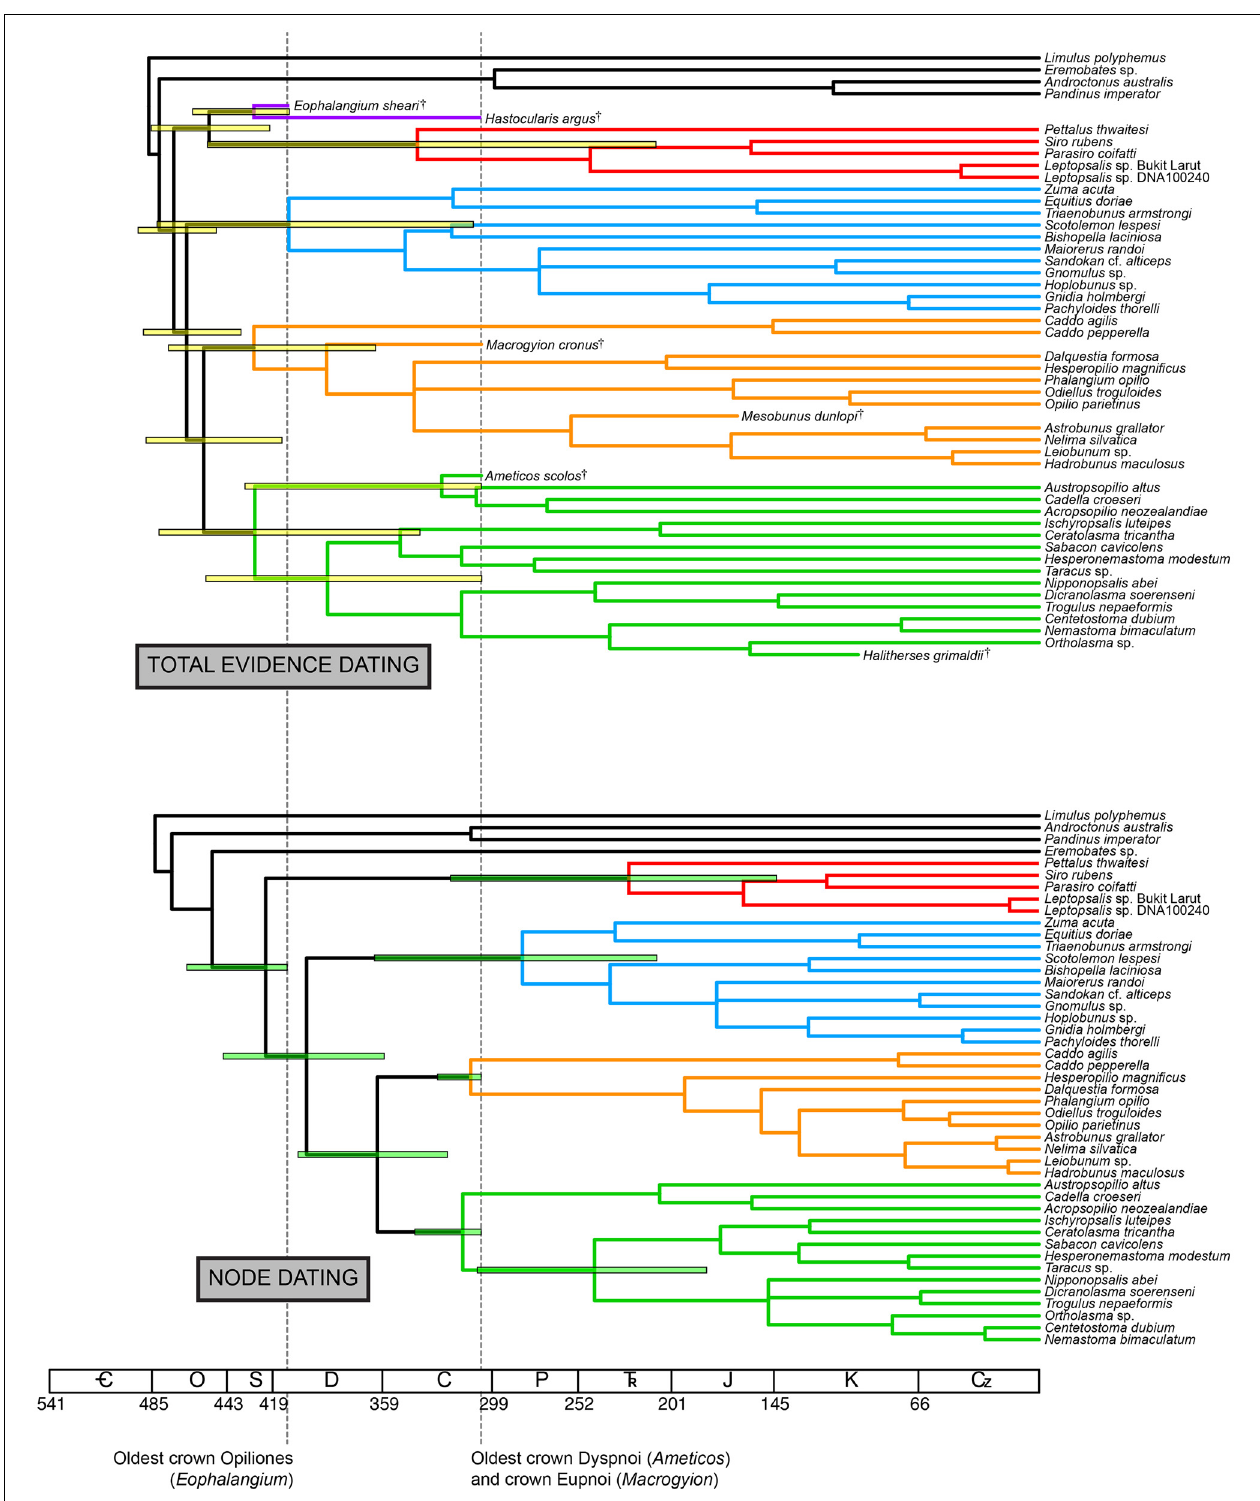
FIGURE 3 |Above: chronogram from total evidence dating under the independent gamma rates model. Below: chronogram from node dating of the total evidence data set (without fossils) under the independent gamma